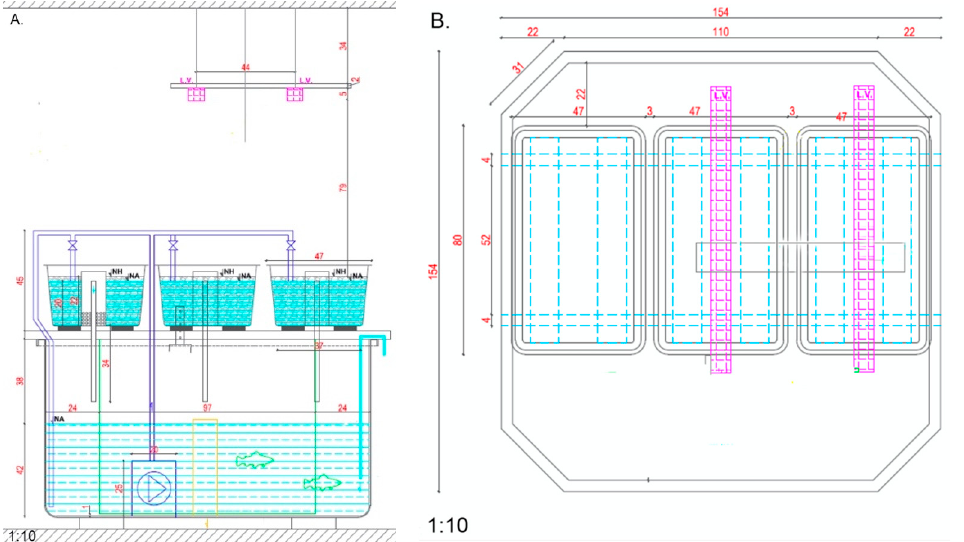
Figure 34. Aquaponics system layout as designed and constructed for the study (( A ). cross section view, ( B ). top view).